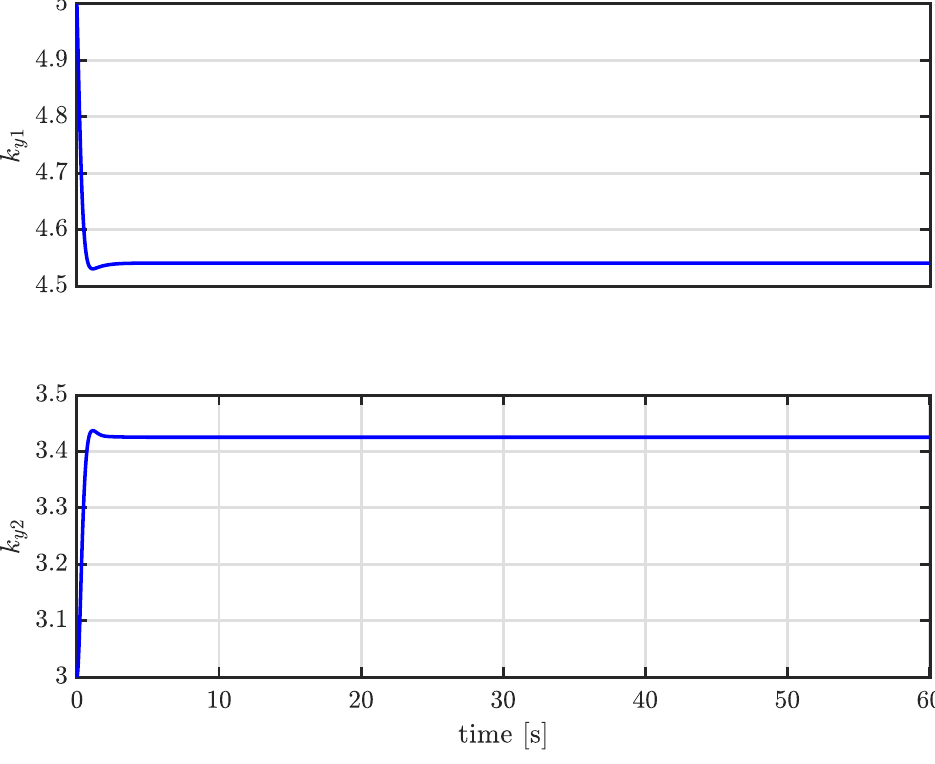
Figure 9. Control gains for yaw control (Case